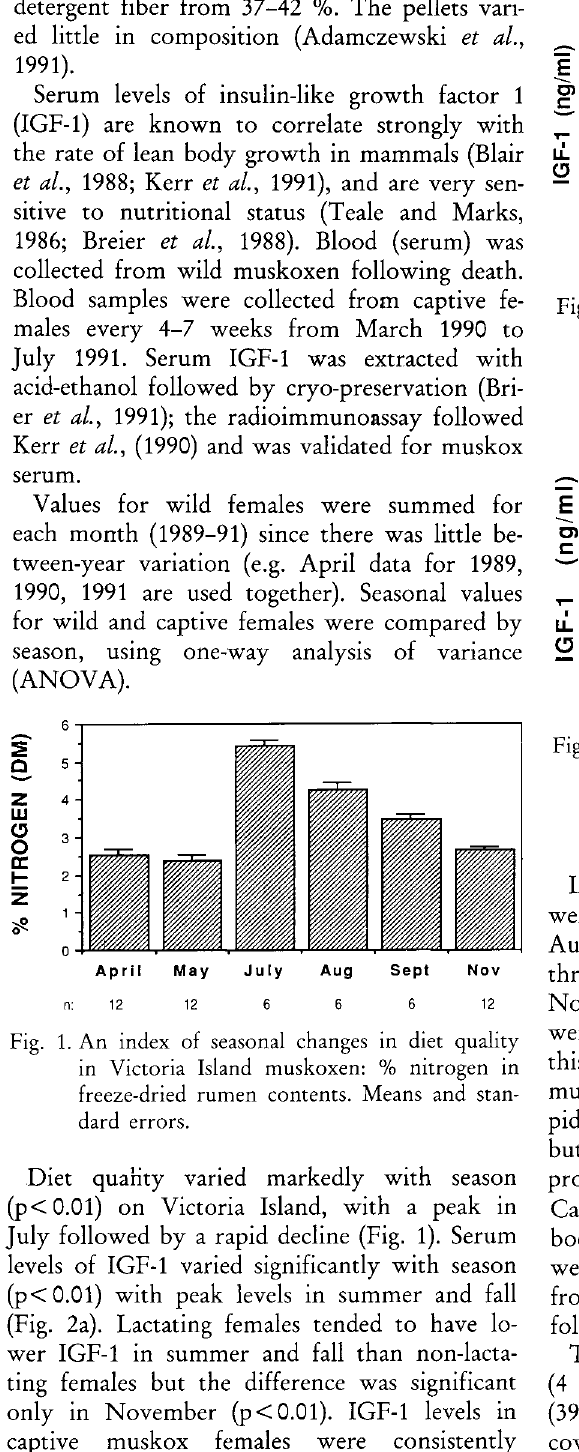
Fig. 2a. Serum IGF-1 levels in Victoria Island muskox females (3 years old or older). Sing le samples from individual animals; means and standard errors.